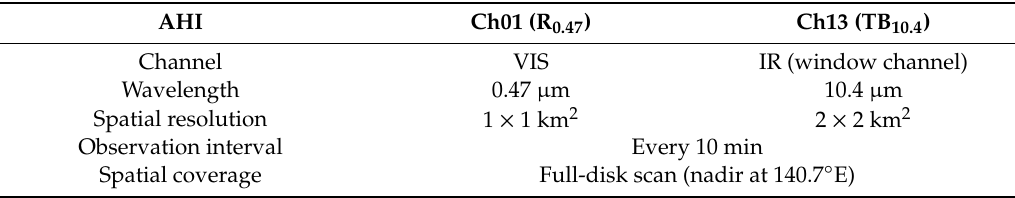
Table 3. AHI VIS and IR channels for DCC detection.